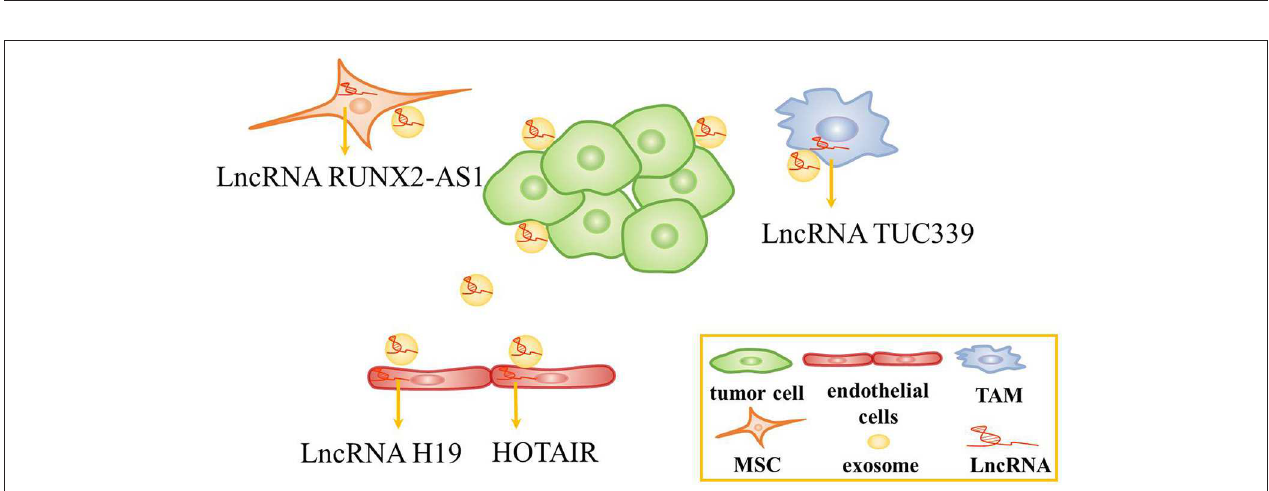
FIGURE 1 | LncRNAs implicated in the crosstalk between stromal cells and tumor cells. Stromal cells include cancer associated fibroblasts (CAFs), endothelial cells, myeloid-derived suppressor cells (MDSCs), tumor-associated macrophages (TAMs), CD8 + T cells, and regulatory T cells (Tregs).